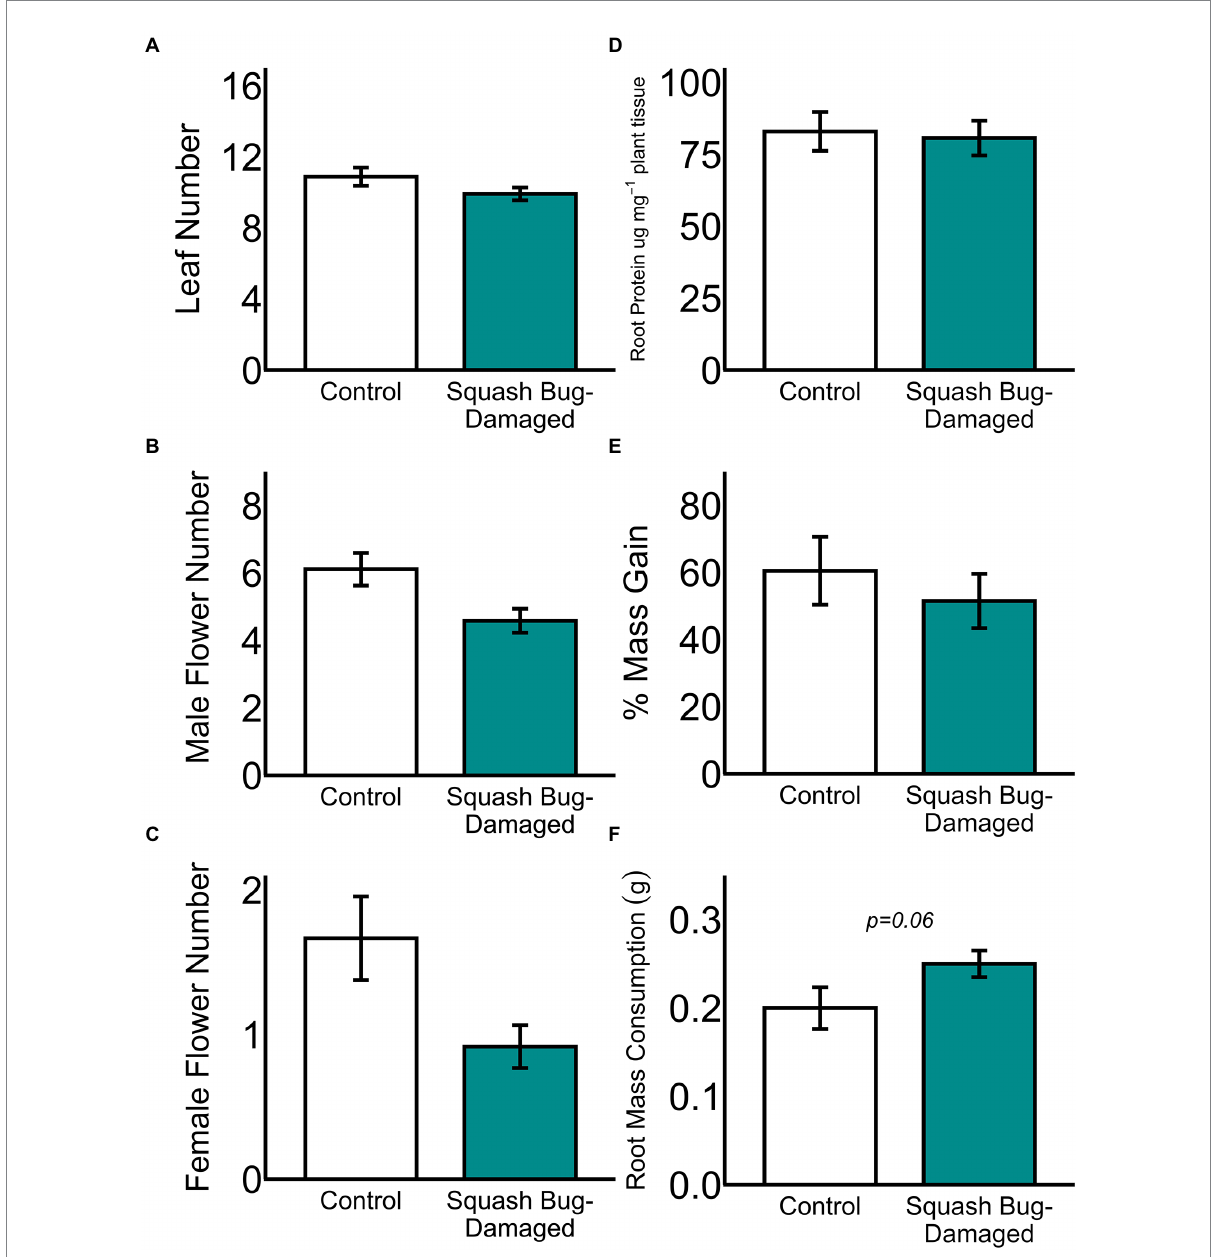
FIGURE 5 Aboveground squash bug herbivory does not modify (A) leaf number, (B) male flower number, (C) female flower number, (D) root protein content, (E) belowground larval mass gain, or (F) belowground larval root mass consumption. (* p ≤ 0.05) Means ± SE are